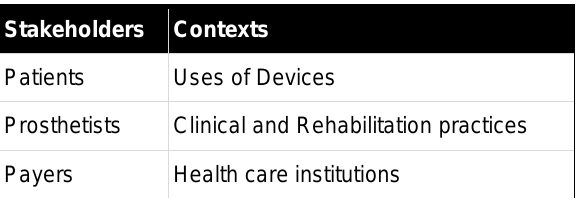
relationships highlighted above.